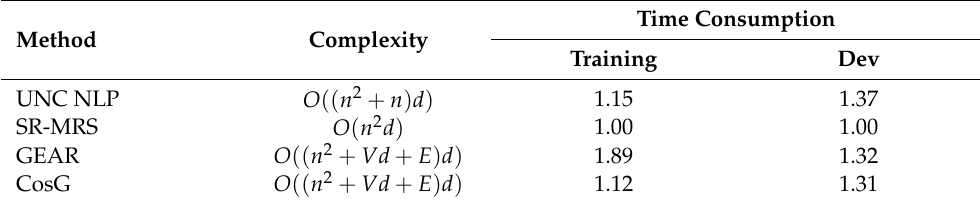
Table 4. Computational complexity and efficiency. We set the training and dev time of SR-MRS to 1 unit, respectively. Then, we can find the relative time cost of each corresponding model against SR-MRS.